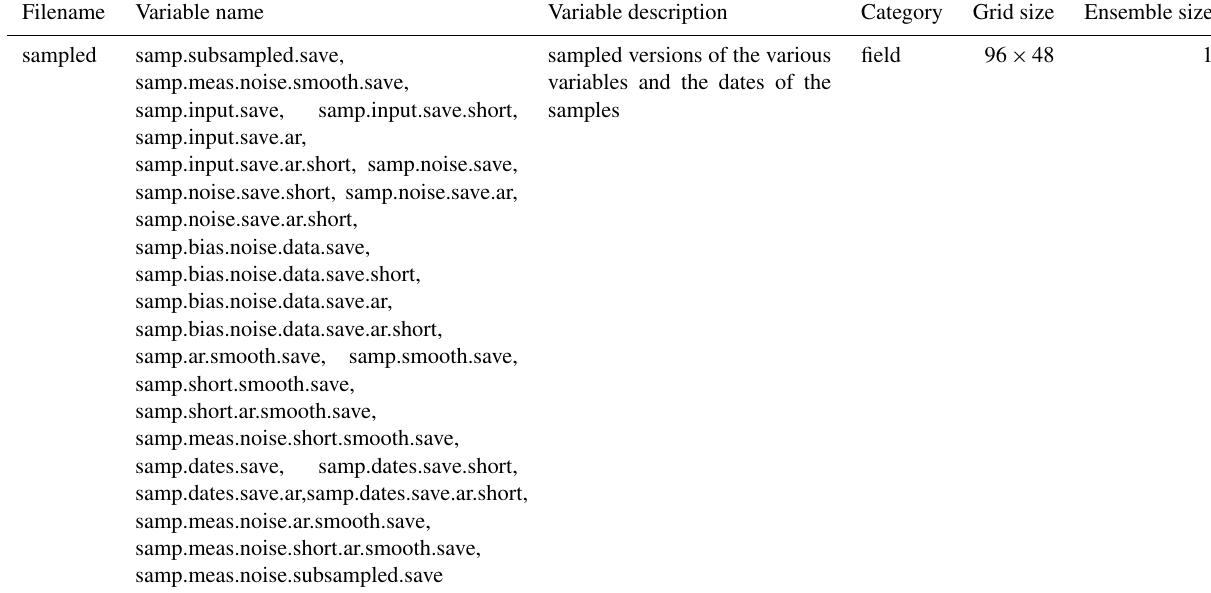
Table 2. Continued list of files provided, the variables included, their description, the category (full surrogate proxy field, essence field, or ensemble), and size of the ensemble. All files have the same stem Bothe_Trace21k_Pseudo_Proxies_ and the ending